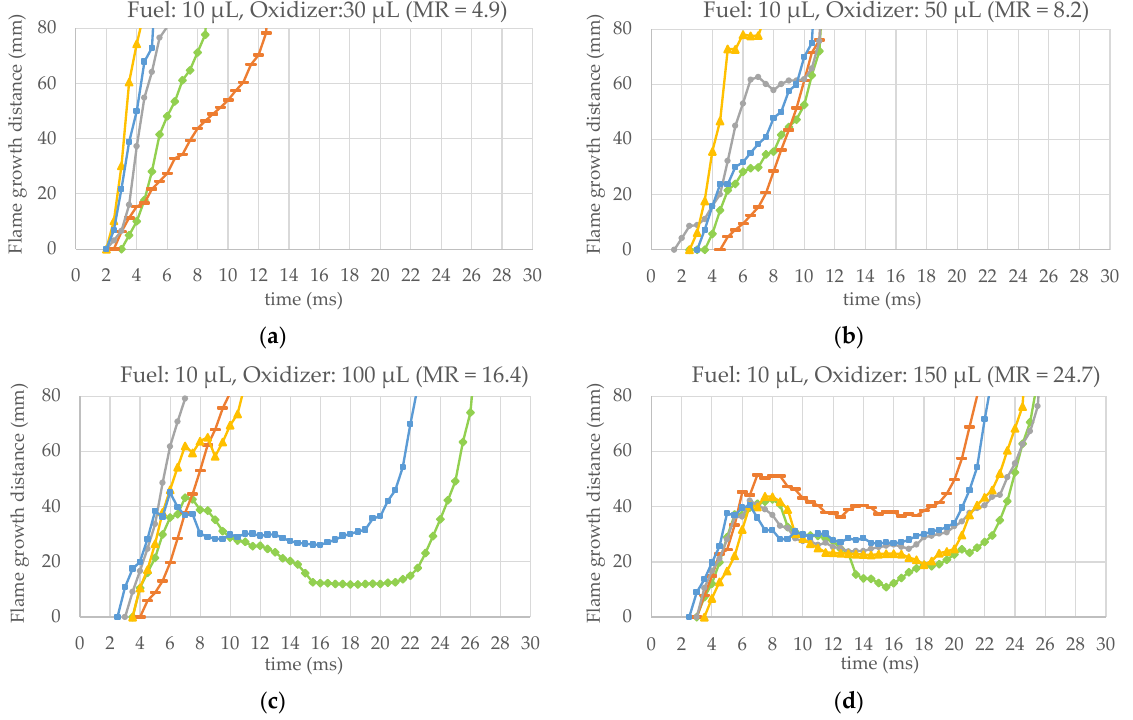
Figure 6. Time history of flame growth in the test tube (( a ) MR = 1.6, ( b ) MR = 8.2, ( c ) MR = 16.4, ( d ) MR = 24.7, five test results for each test condition are plotted per graph).